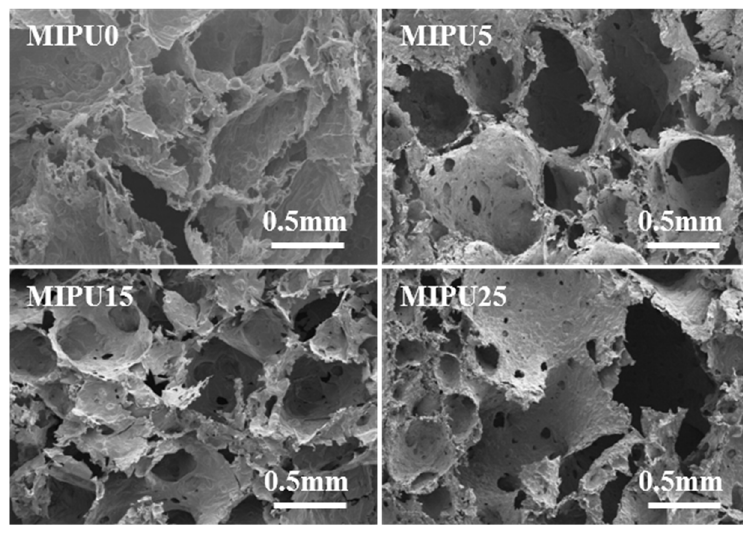
Figure 9. SEM images of the internal section of the expanded char.